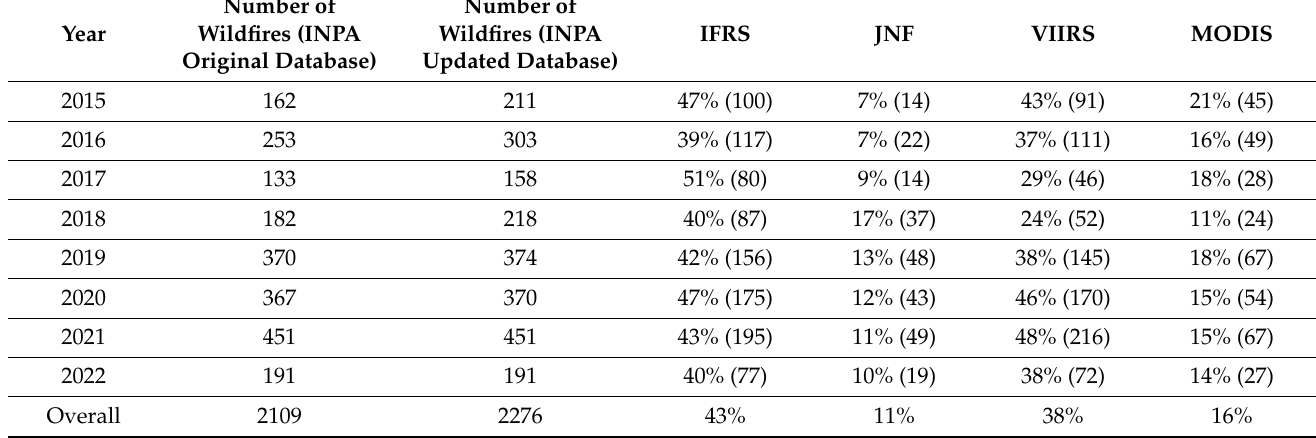
Table 3. Number and percent of wildfire events that were joined from each database source to the updated INPA database. The percentage was calculated compared to the INPA total wildfires number each year. The number in parentheses indicates the total number of matched wildfires